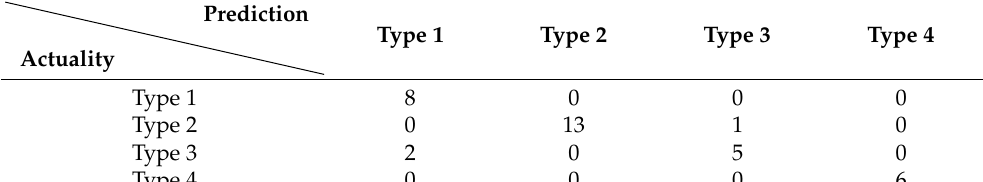
Table 3. Confusion matrix of the RF classifier.